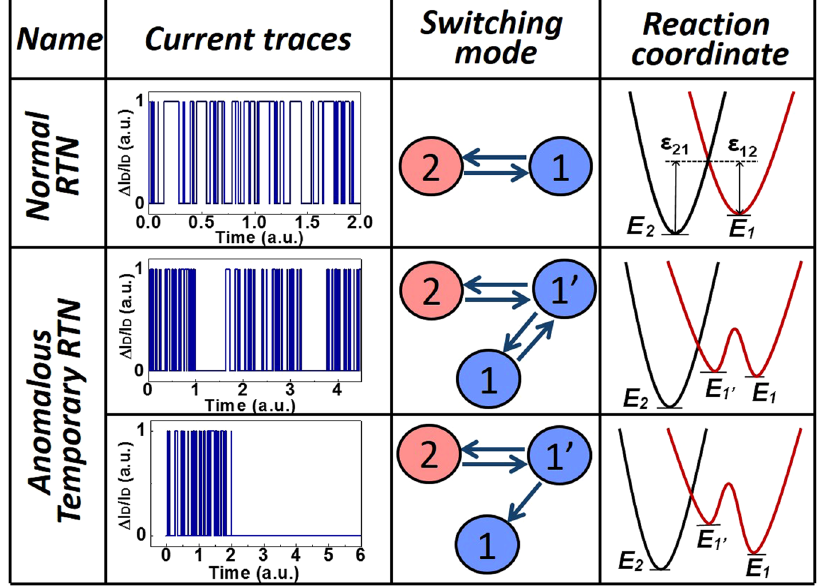
Figure 1. The illustrations of the current traces, switching modes and the corresponding reaction coordinate of the normal RTN and two patterns of anomalous temporary RTN 9, 10 (tRTN), where state 2 is charged state, and state 1 and metastable state 1 ′ are neutral state.